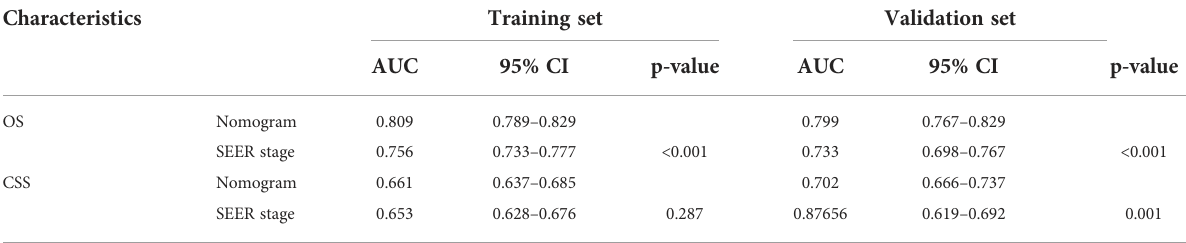
TABLE 4 Comparison of area under the curve (AUC) between the nomogram and SEER stages in patients with malignant adrenal tumors.